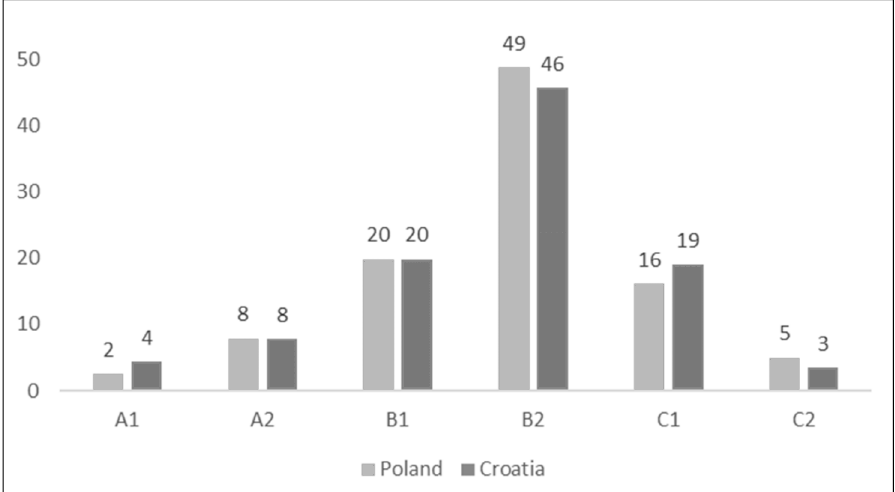
Figure 1. Participants by language competence in English